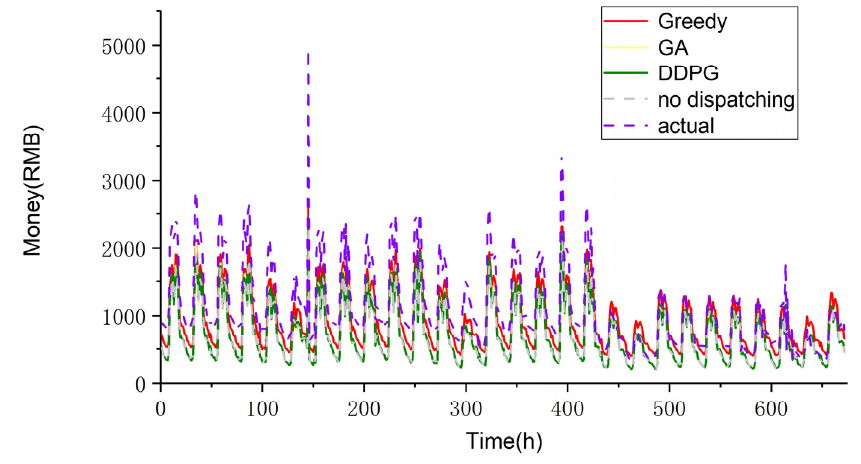
Figure 15. Change of money of energy management experiments .